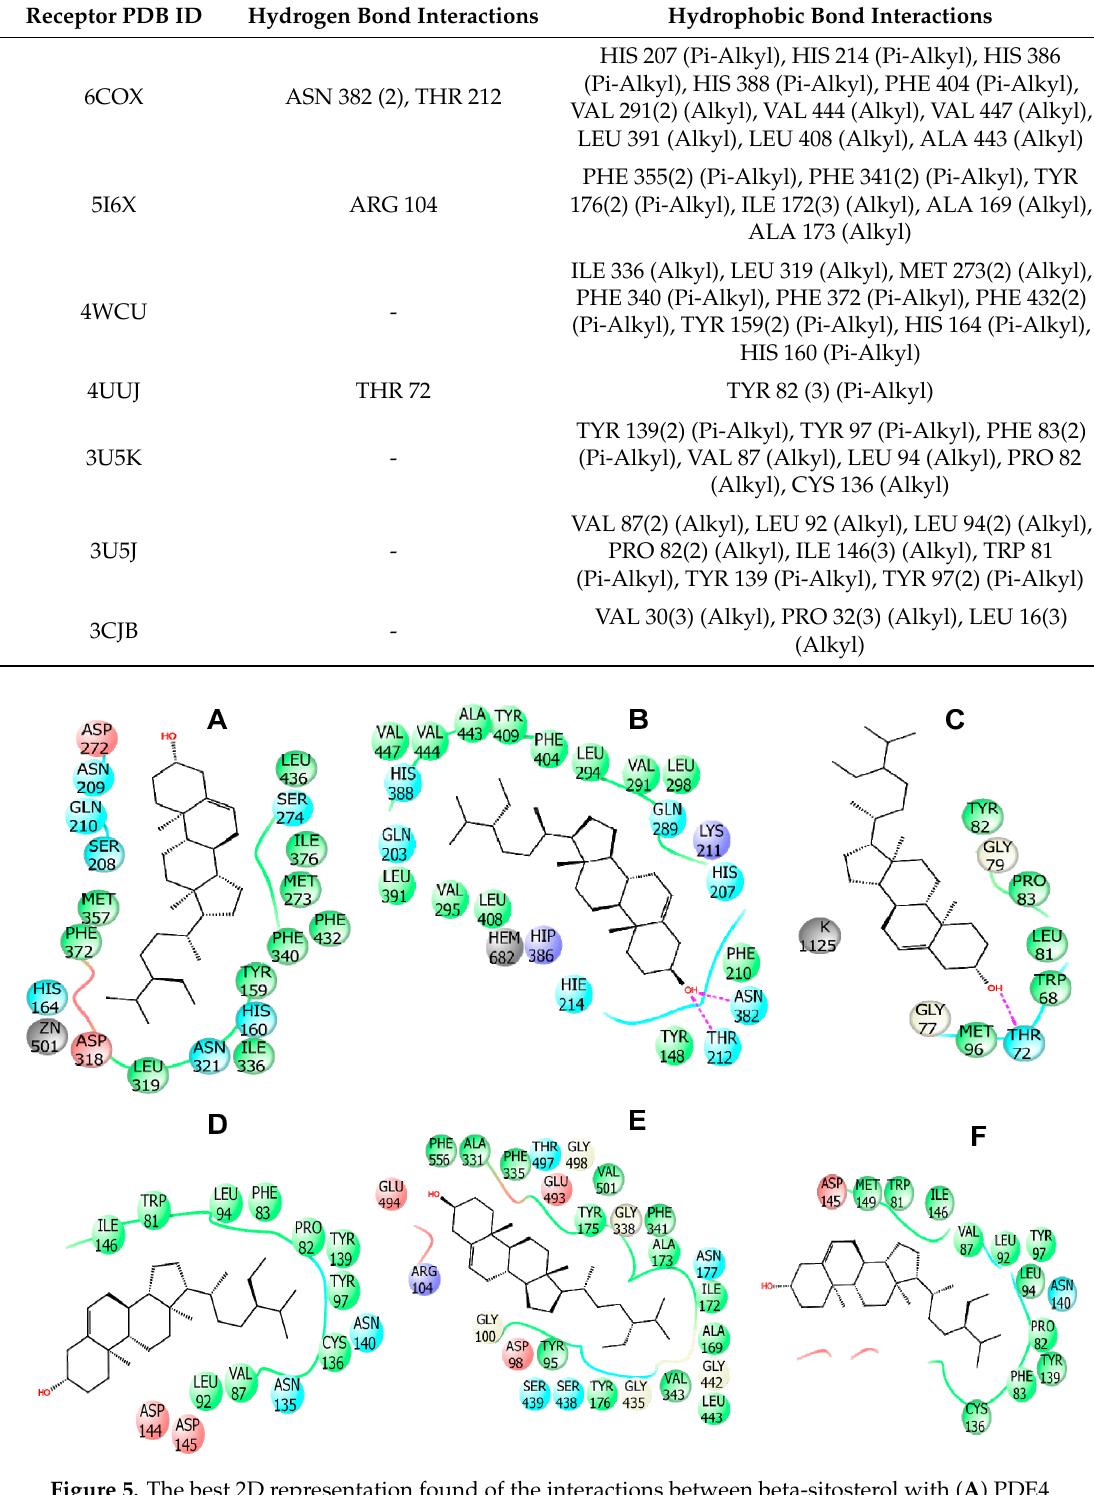
Table 8. Binding interactions of the beta-sitosterol with the respective proteins for di ff erent biological activities.